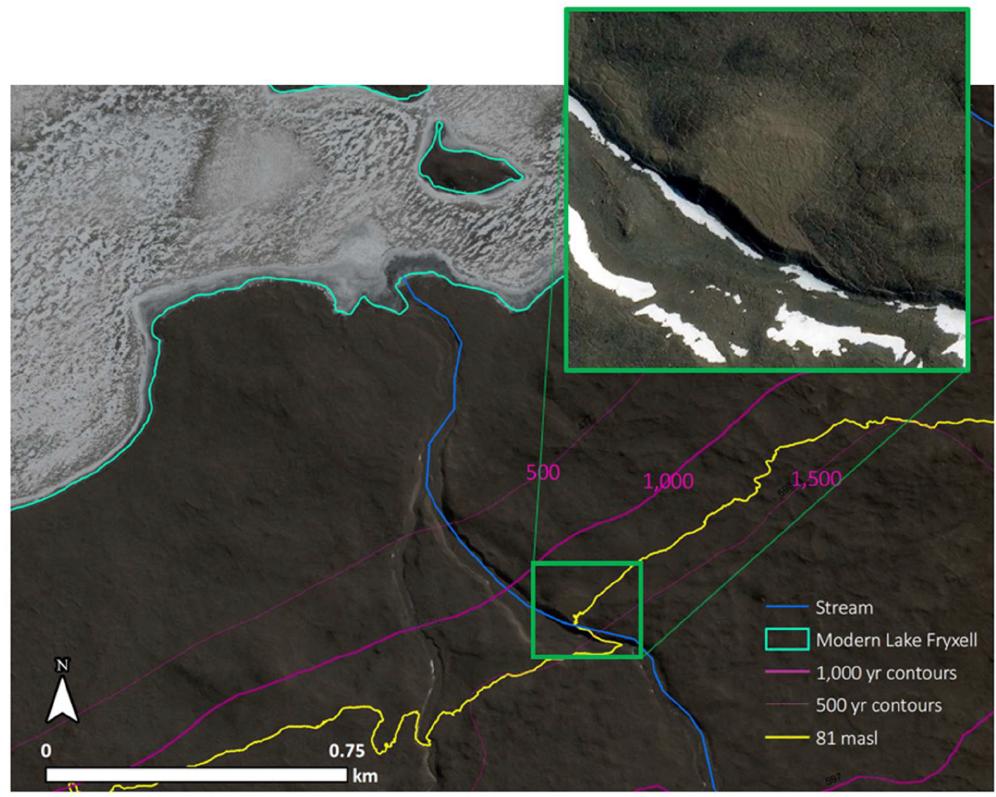
Figure 18. Maximum permafrost ages calculated using the analytical model (Eq. 1) are shown as pink contours and indicate roughly 1.5ka permafrost at 81ma.s.l. (yellow elevation contour). An extremely well-preserved delta on Crescent Stream is located at roughly 81ma.s.l. and shown in inset map (green box). Image © 2017 DigitalGlobe, Inc. provided by the Polar Geospatial